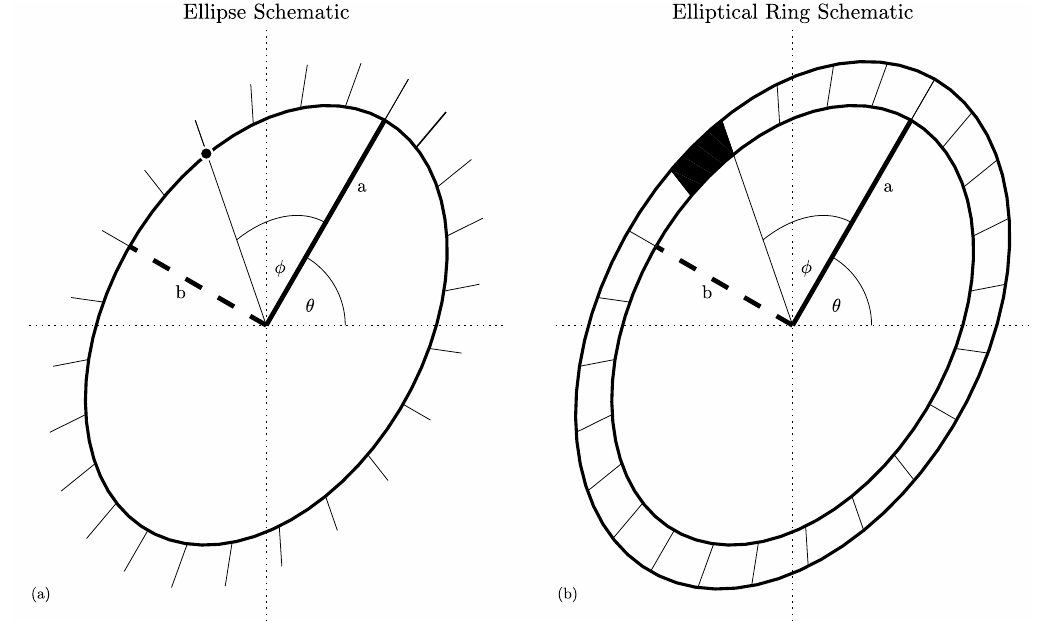
Figure 3. Schematics for ( a ) an ellipse and ( b ) an elliptical ring or annulus. In both panels, the semi-major and semi-minor axes a and b are denoted by heavy solid and heavy dashed lines, respectively, while the location of one particular particle along the periphery is marked with a thin solid line. The ellipse orientation angle θ , measured counterclockwise from the x -axis, and the phase angle φ to the particle location from the major axis are also shown. The twenty-four “spokes” around the ellipse mark uniform increments of ∆ φ = π /48 radians in the phase angle φ . In (b), two concentric ellipses of identical shape and orientation, but slightly different sizes, are drawn. The space between these two ellipses forms an elliptical ring or annulus , with the phase angle φ now taken to mark parcels , shown later to have the same area, as opposed to simply a location around the ellipse periphery. The parcel between the indicated phase angle φ and φ + ∆ φ is filled in with dark